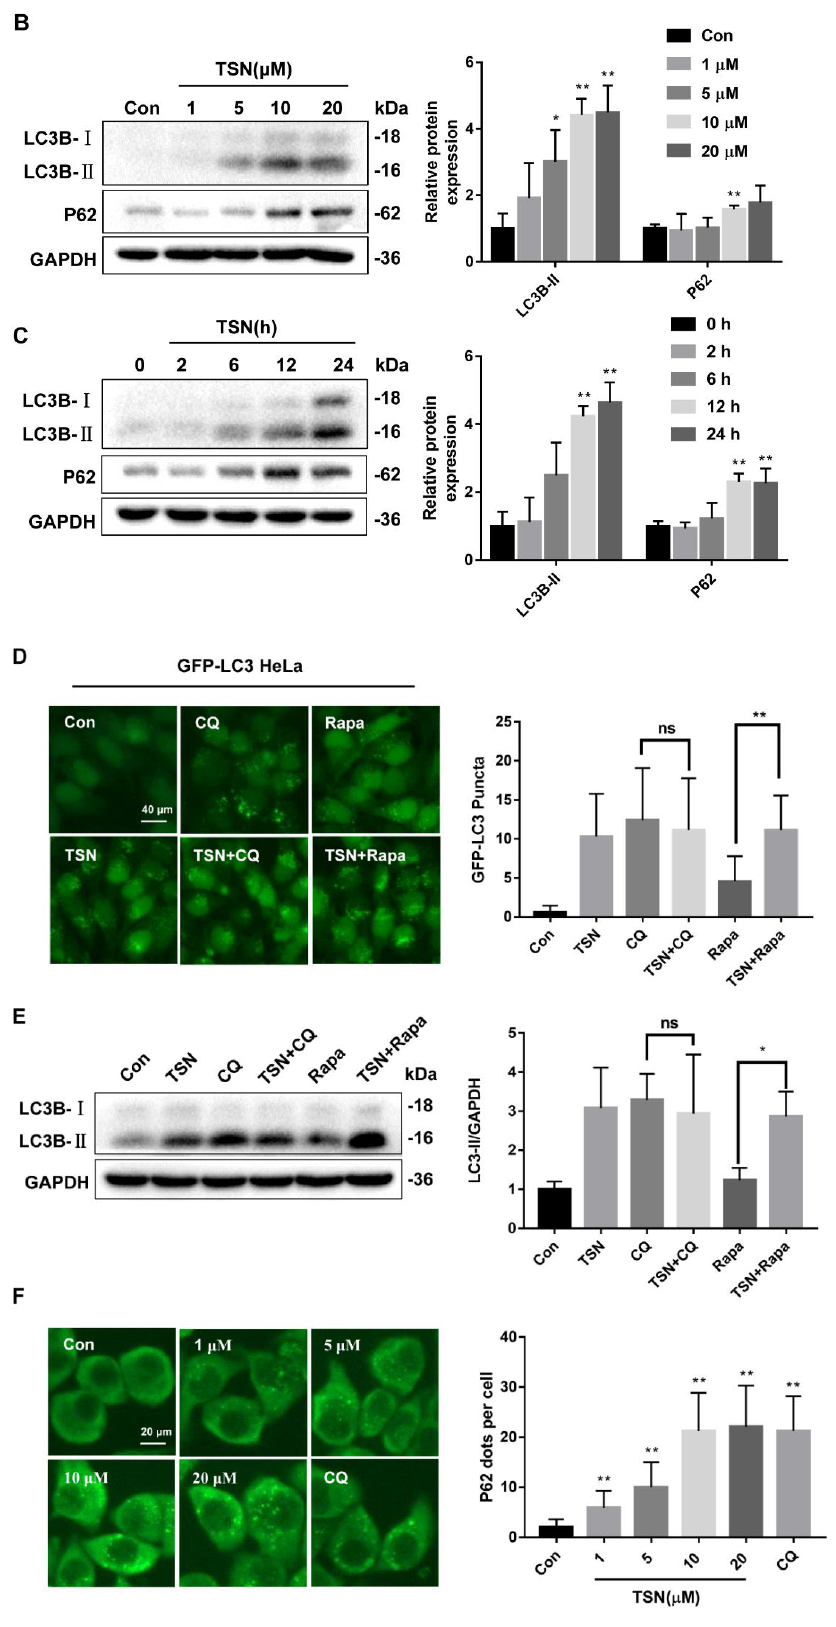
Figure 2. TSN inhibited autophagic flux in HepG2 cells. ( A ) HeLa cells expressing GFP-LC3 were treated with TSN for 6 h at different concentrations (1, 5, 10, 20 μM) or were treated with TSN (10 μM) over a certain time course (0, 2, 6, 12, 24 h). The distribution of GFP-LC3 was examined, and the number of GFP- LC3 puncta was quantified. Scale bar: 40 μm. ( B ) HepG2 cells treated with TSN for 6 h at different concentrations (1, 5, 10, 20 μM) were analyzed by Western blotting for the protein levels of LC3B and P62. The ratios of LC3B- Ⅱ /GAPDH and P62/GAPDH were calculated using ImageJ software. ( C ) HepG2 cells treated with TSN (10 μM) over a certain time course (0, 2, 6, 12, 24 h) were analyzed by Western blotting for the protein levels of LC3B- Ⅱ and P62. The ratios of LC3B- Ⅱ /GAPDH and P62/GAPDH were calculated using ImageJ software. ( D ) HeLa cells expressing GFP- LC3 were treated by TSN (10 μM) with or without chloroquine (CQ, 40 μM) or rapamycin (Rapa, 1 μM) for 6 h. The distribution of GFP -LC3 was examined, and the number of GFP-LC3 puncta was quantified. Scale bar: 40 μm. ( E ) HepG2 cells were treated by TSN (10 μM) with or without CQ (40 μM) or Rapa (1 μM) for 6 h. The endogenous LC3B was analyzed by Western blotting, and the ratio of LC3B- Ⅱ /GAPDH was calculated using ImageJ software. ( F ) HepG2 cells were treated with TSN at different concentrations (1, 5 10, 20 μM) or CQ (40 μM) for 6 h. Cellular immunofluorescence staining was used to detect P62, and the number of P62 puncta was quantified. Scale bar: 20 μm. Data are presented as the mean ± SD of three independent experiments. * p < 0.05, ** p < 0.01 versus control; ns, not significant.